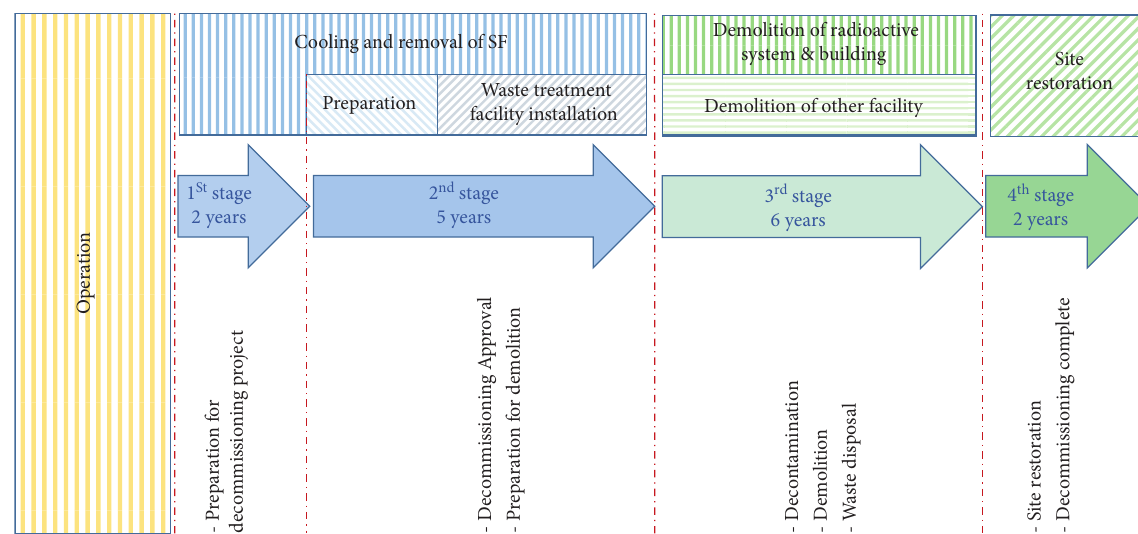
Figure 2: Barakah site decommissioning